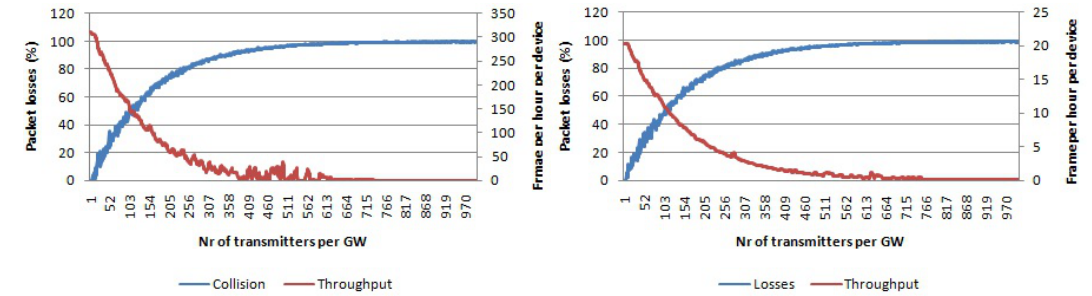
Figure 13. Percentage of packets lost due to collisions per number of transmitters per gateway using pure Aloha access. Average throughput per device. Multiple channels, single SF and payload size 20 bytes. ( left ) Using SF 7; ( right ) using SF 12.